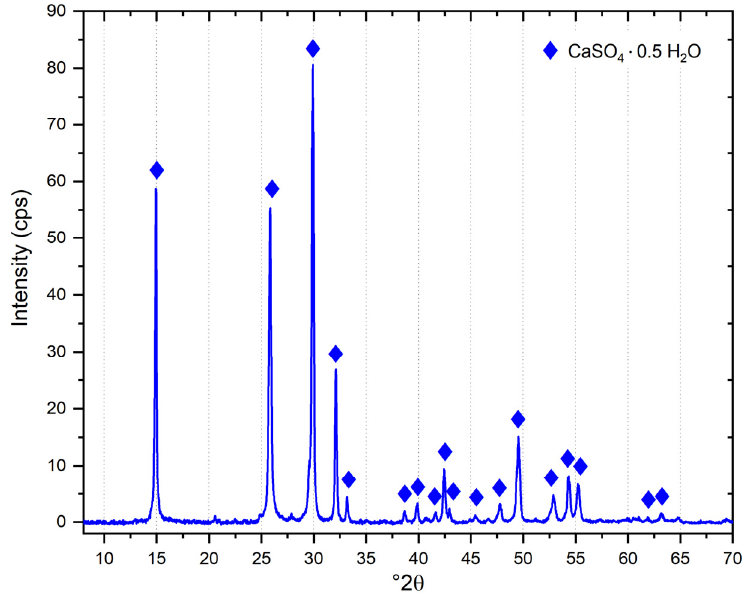
Figure 16. α -HH out of dihydrate after 240 min of hydration.